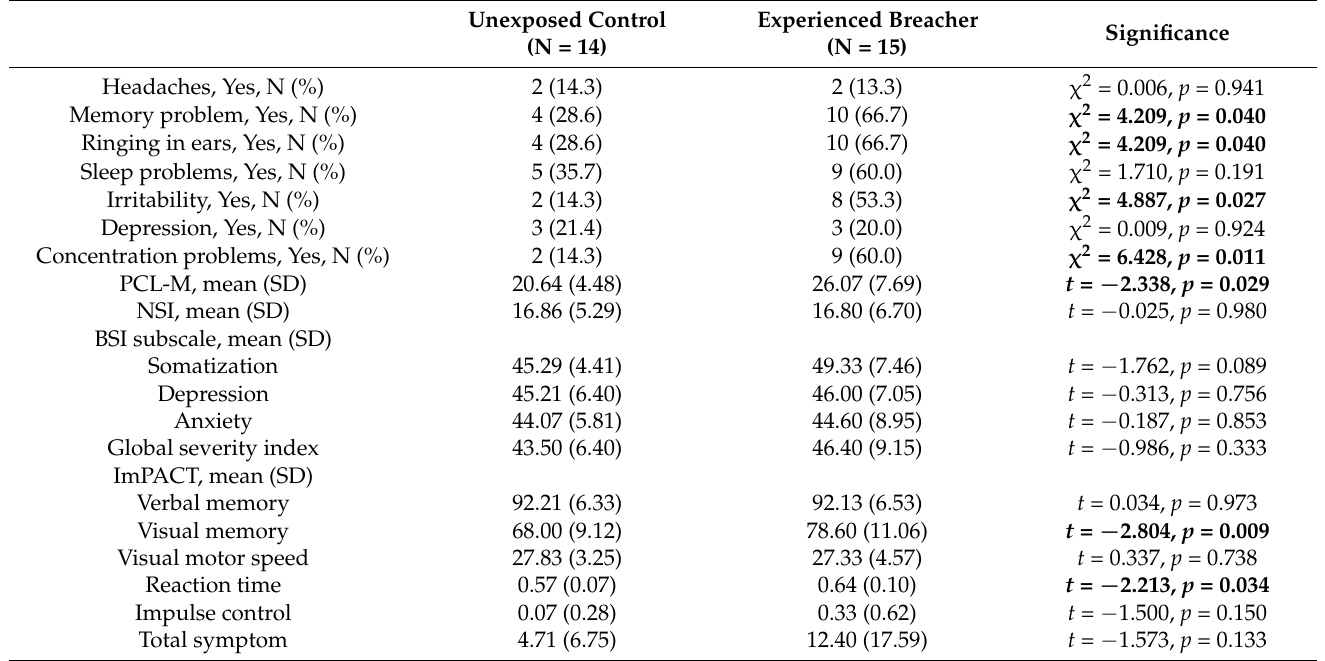
Table 2. Clinical symptoms of study participants.